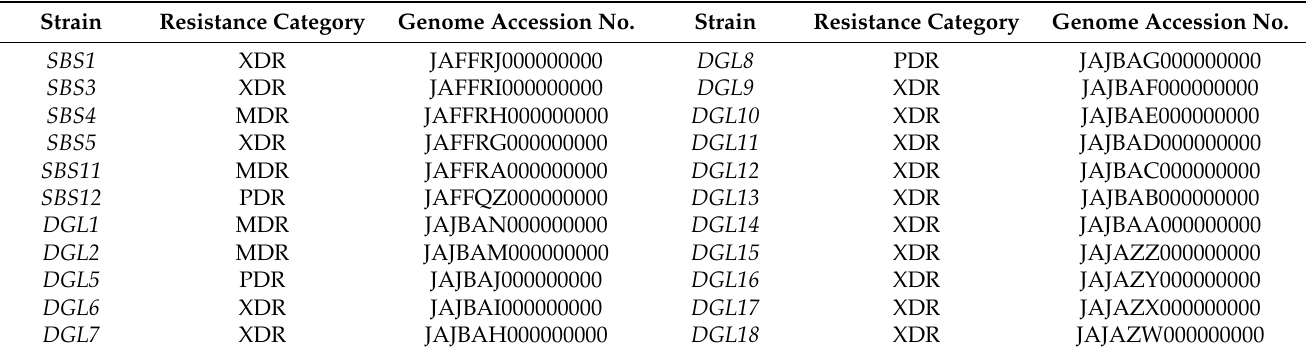
Table 1. List of isolates (strain) with resistance category and genome accession number submitted in NCBI (Bioproject no: